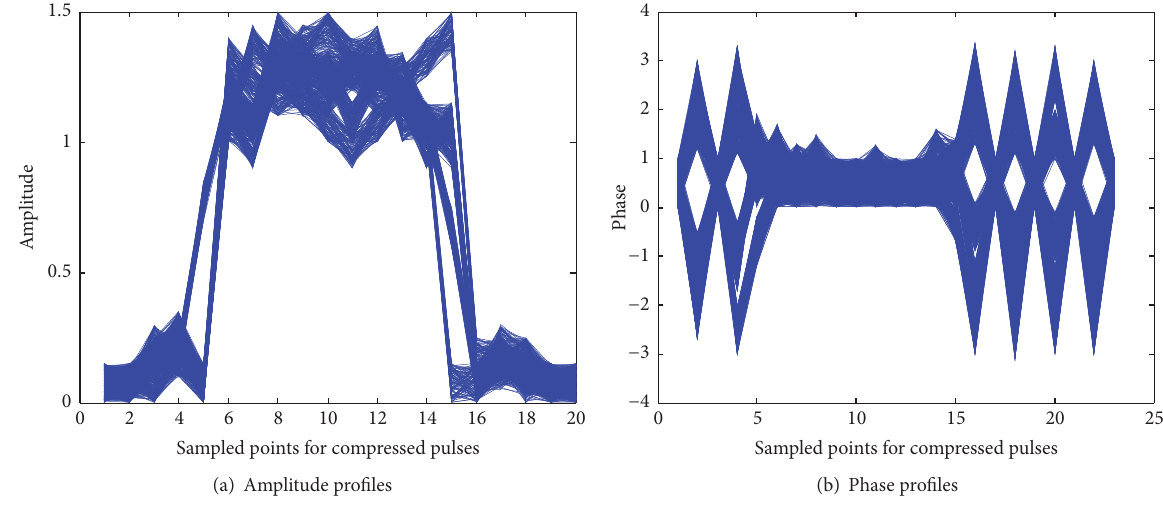
Figure 13: Amplitude and phase profiles of 600 compressed preprocessed radar pulses. Table 7: Performance results for 120